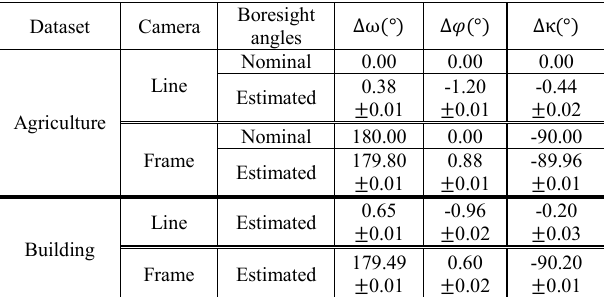
Table 2. The nominal and estimated boresight angles along with their standard deviations for the two datasets.